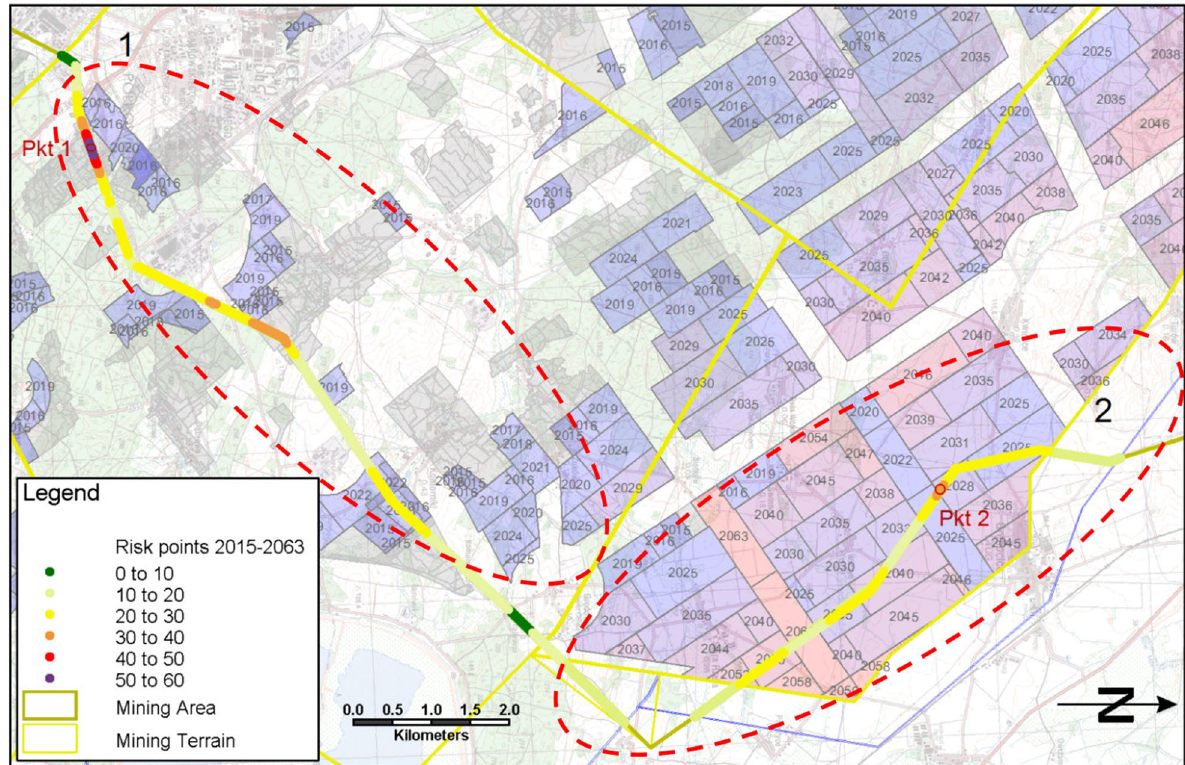
Fig. 7 Evaluation of risk of pipeline failure with fuzzy